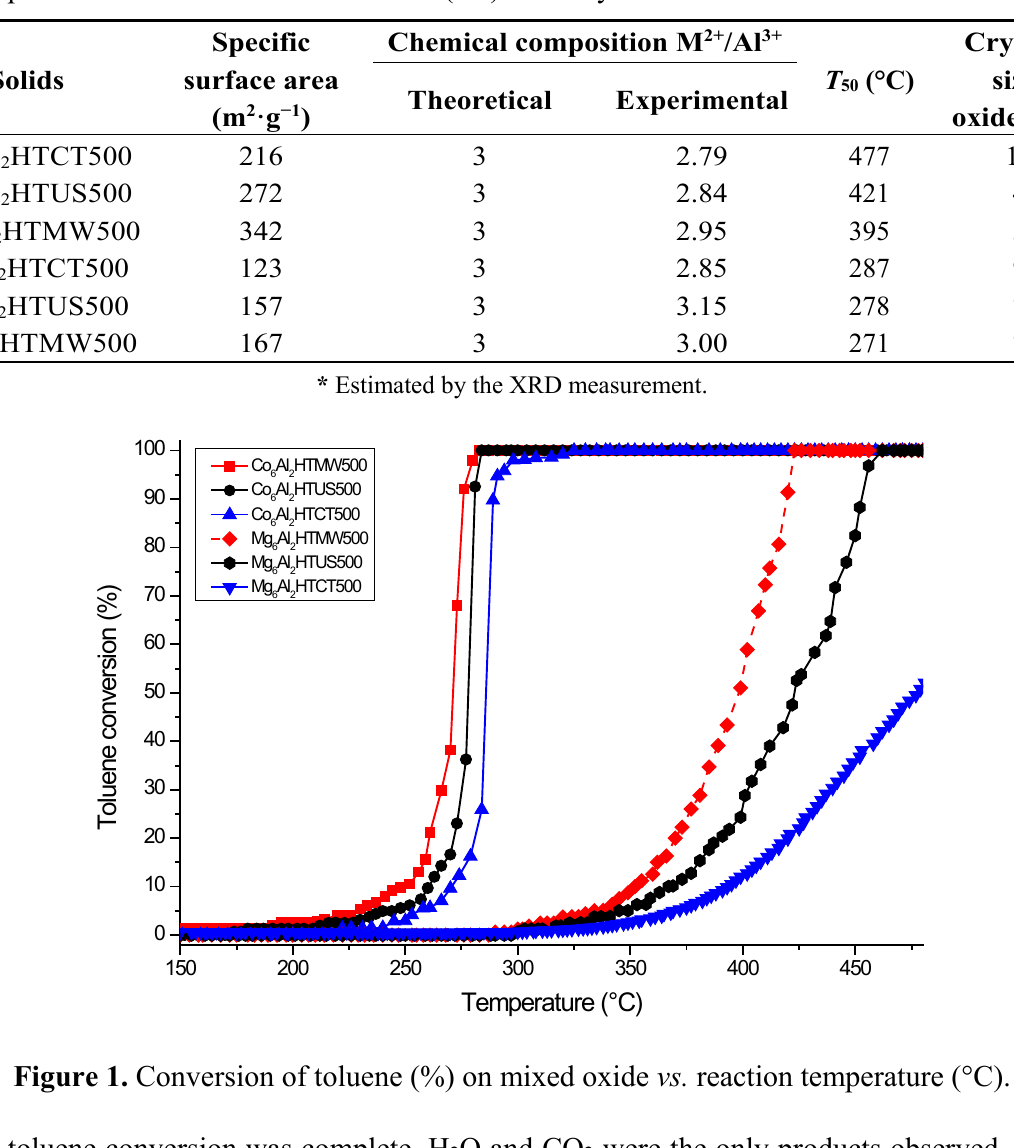
Table 1. Code name, BET specific area, chemical composition, crystallite size and temperature of 50% toluene conversion ( T 50 ) of catalysts.